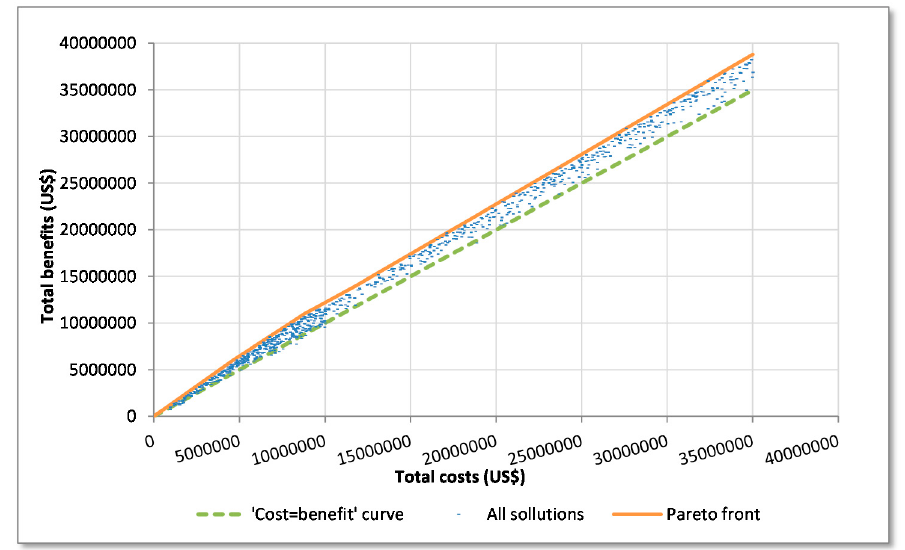
Figure 10. The Pareto-front relating total cost and total benefits for Case 1 (SuDS without underground storage; benefits including ES). The dots represent sub-optimal solutions, which are not a part of the final optimal results.